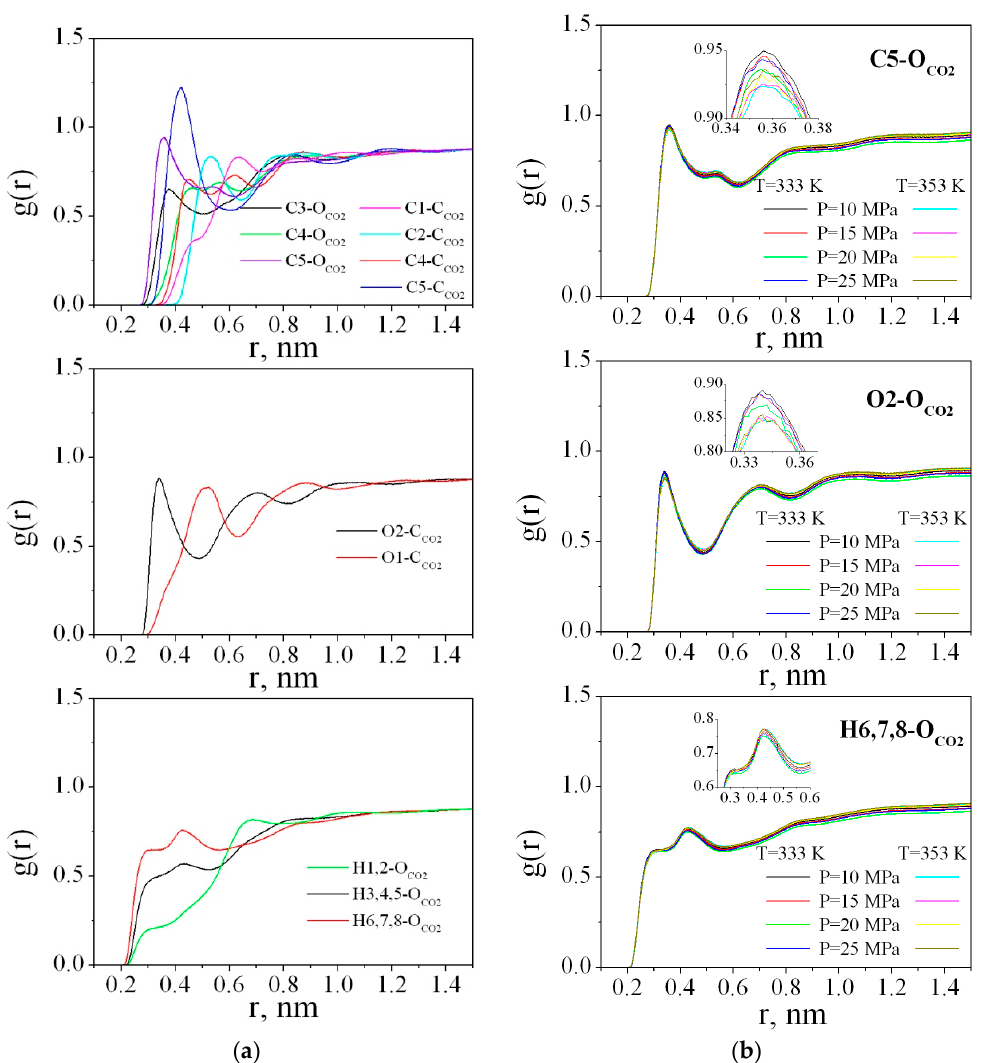
Figure 9. Radial distribution functions of PMMA and CO 2 atoms: ( a ) at 333 K and 25 MPa; ( b ) C5-O CO2 , O2-C CO2 , and H6,7,8-O CO2 for all thermodynamic states.